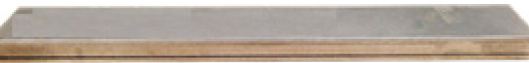
Figure 1: Composite floor sample (400 × 60 × 22mm 3 ).